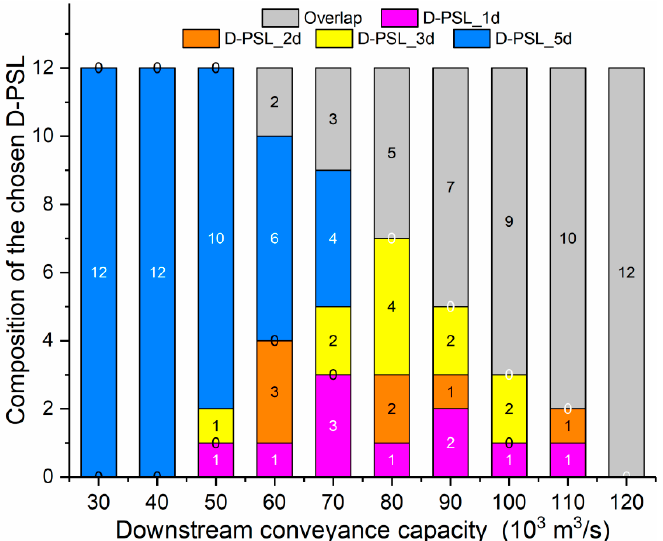
Figure 8. The contribution, as notified by the numbers on the pillars, of chosen D-PSL from four different periods D-PSL ts of 12 selected floods.